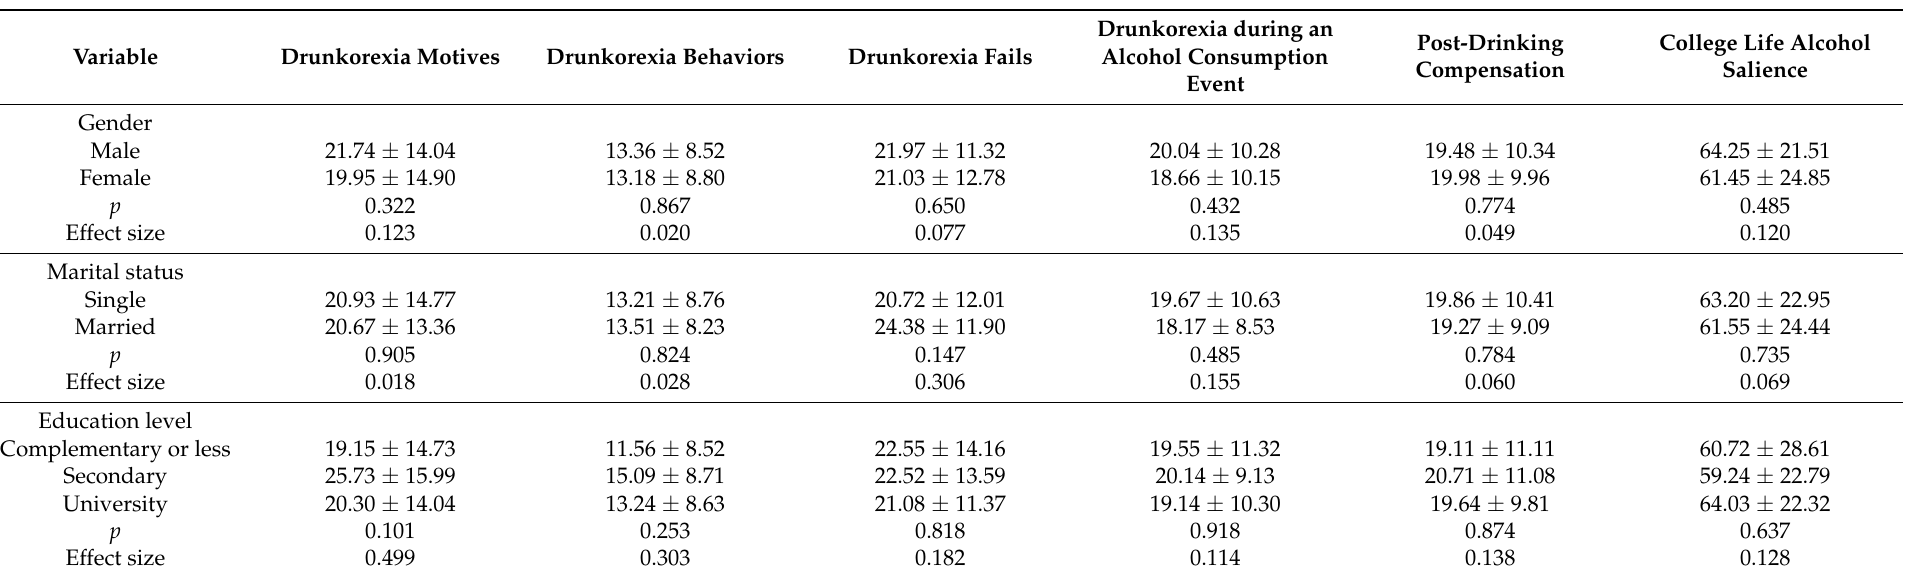
Table 3. Bivariate analysis of continuous variables associated with the drunkorexia